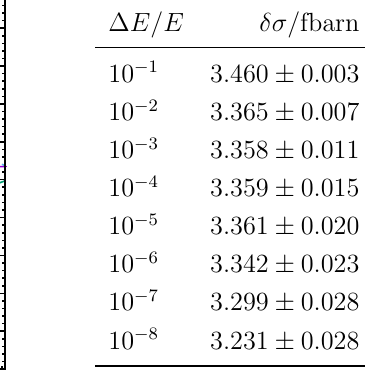
Fig. 2 Phase space slicing method. The different contributions to the one-loop corrections δσ( e + e − → ˜ e +